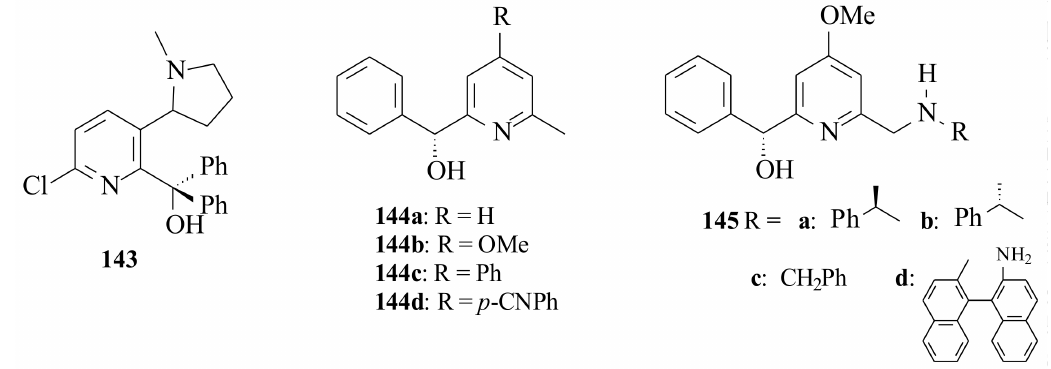
Figure 29. Pyridinyl alcohol compounds substituted on the pyridinyl